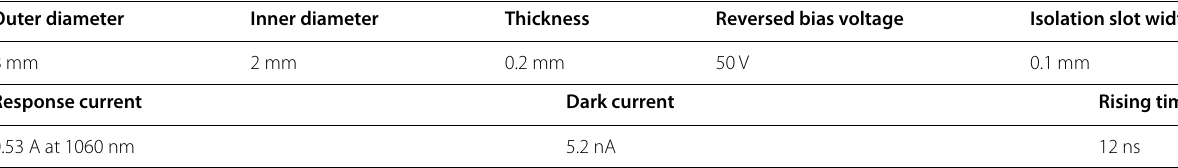
Table 1 The geometry parameters of structure